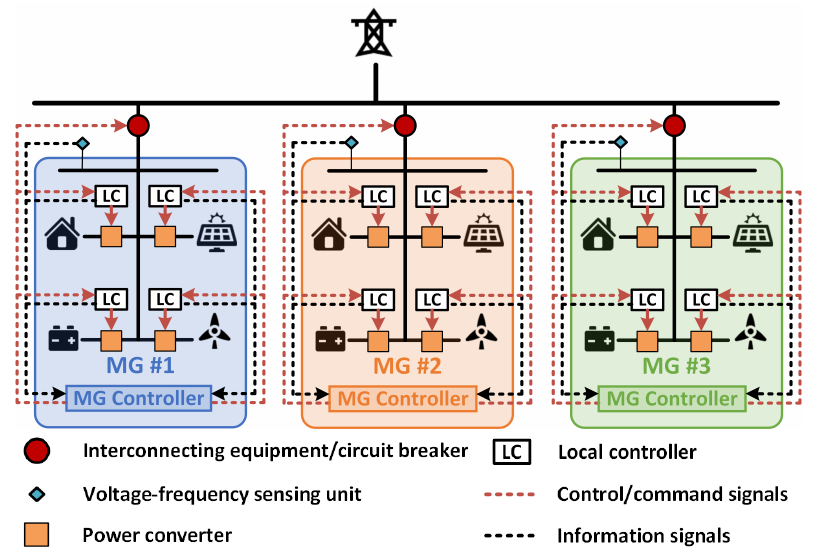
Figure 3. Decentralized control